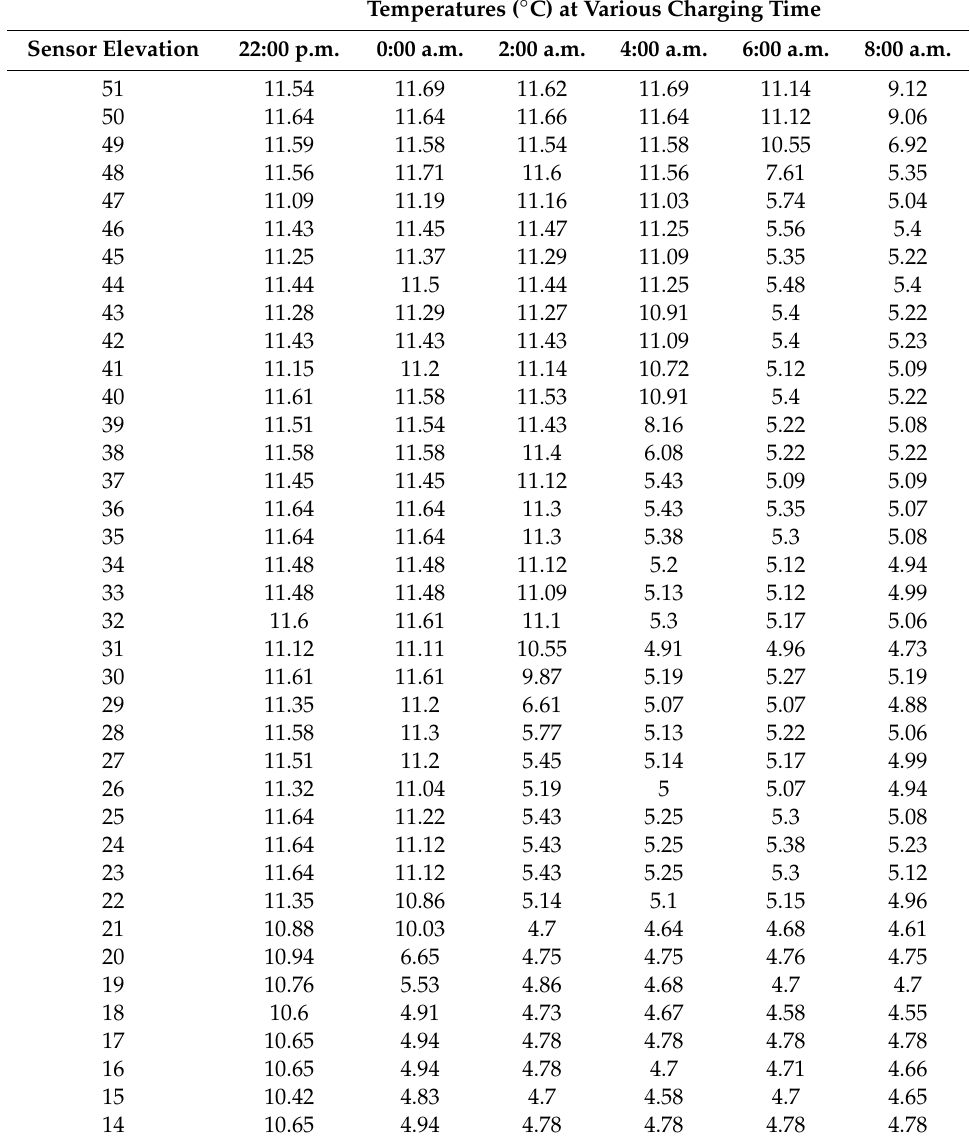
Table A1. Sample of Sensor temperature Readings in a DC plant (for 1st–2nd October